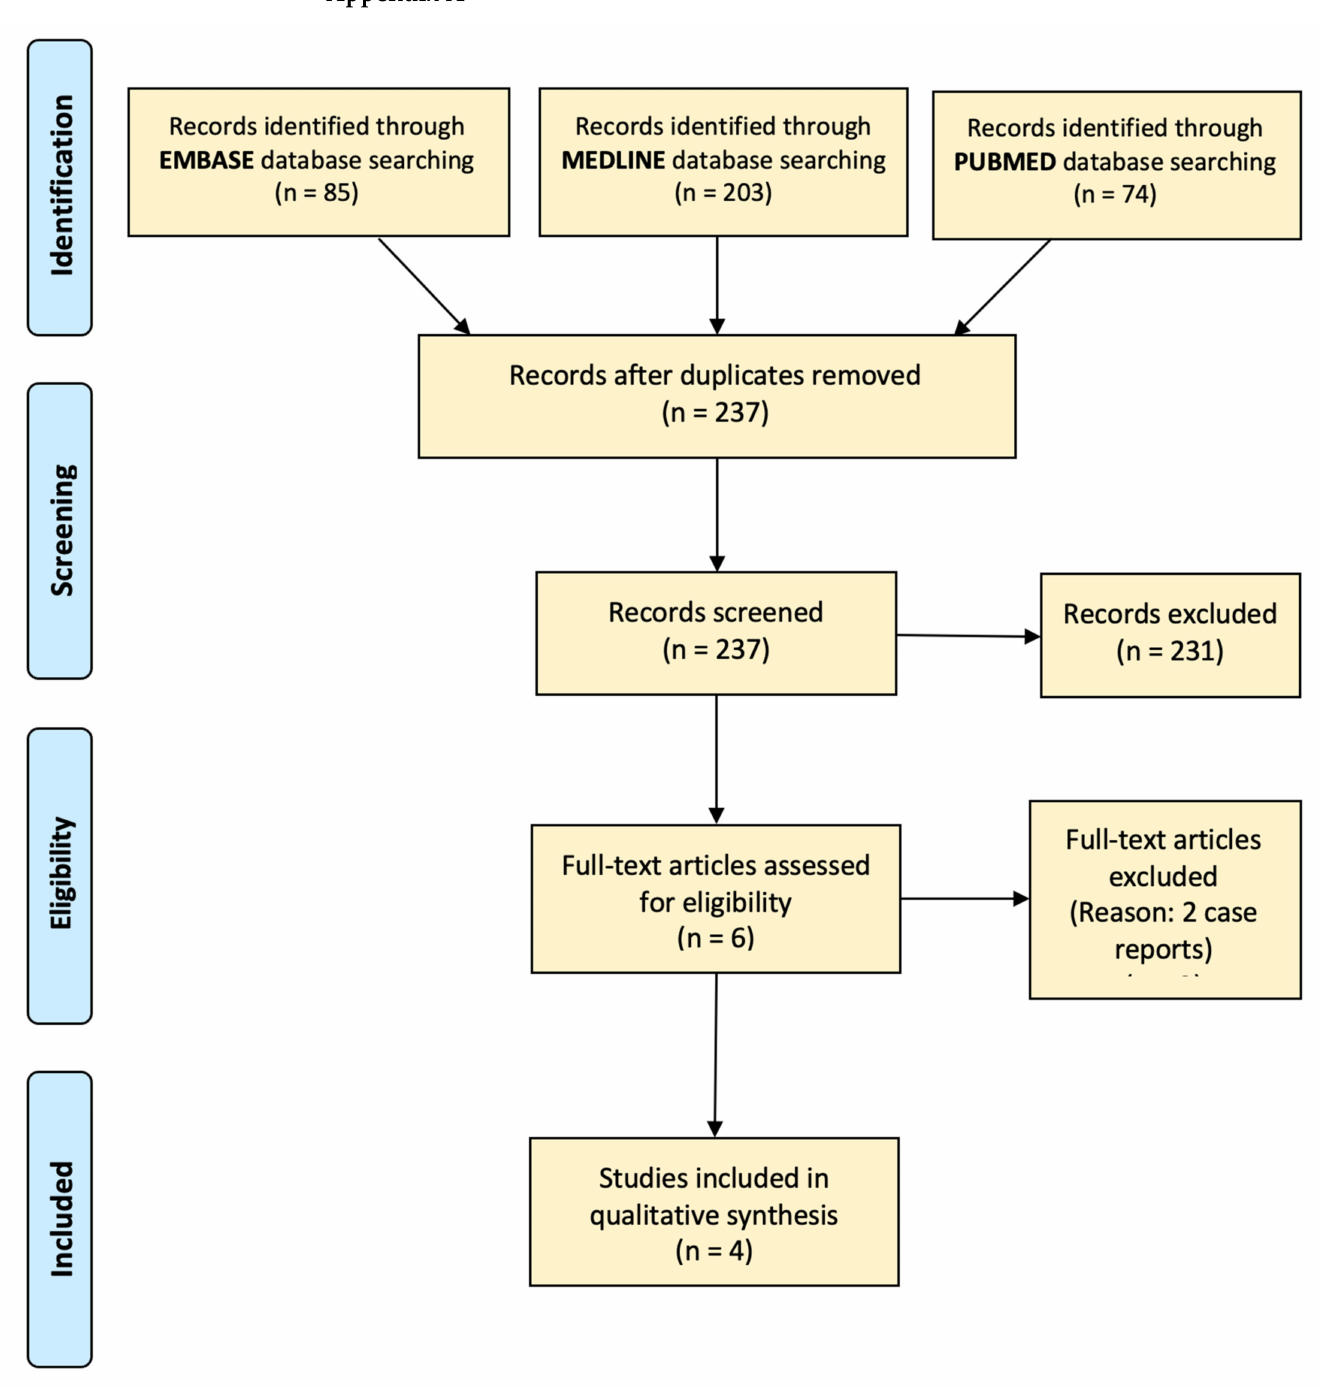
Figure A1. PRISMA flowchart for the systematic search strategy employed for the literature review. 2 databases were searched, yielding 4 relevant